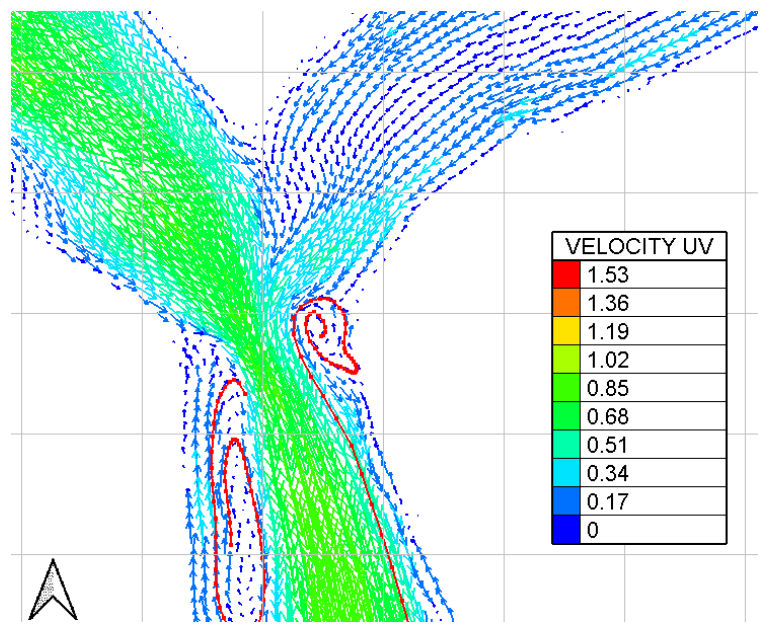
Figure 8. Average flow velocity (VELOCITY UV) in the dry season in 2018 (m/s).